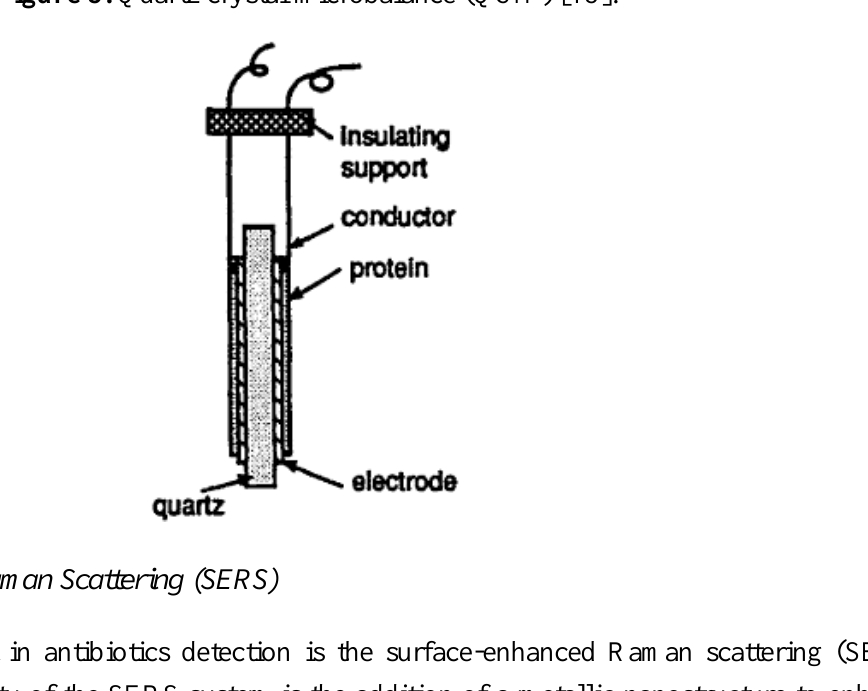
Figure 5. Quartz crystal microbalance (QCM)